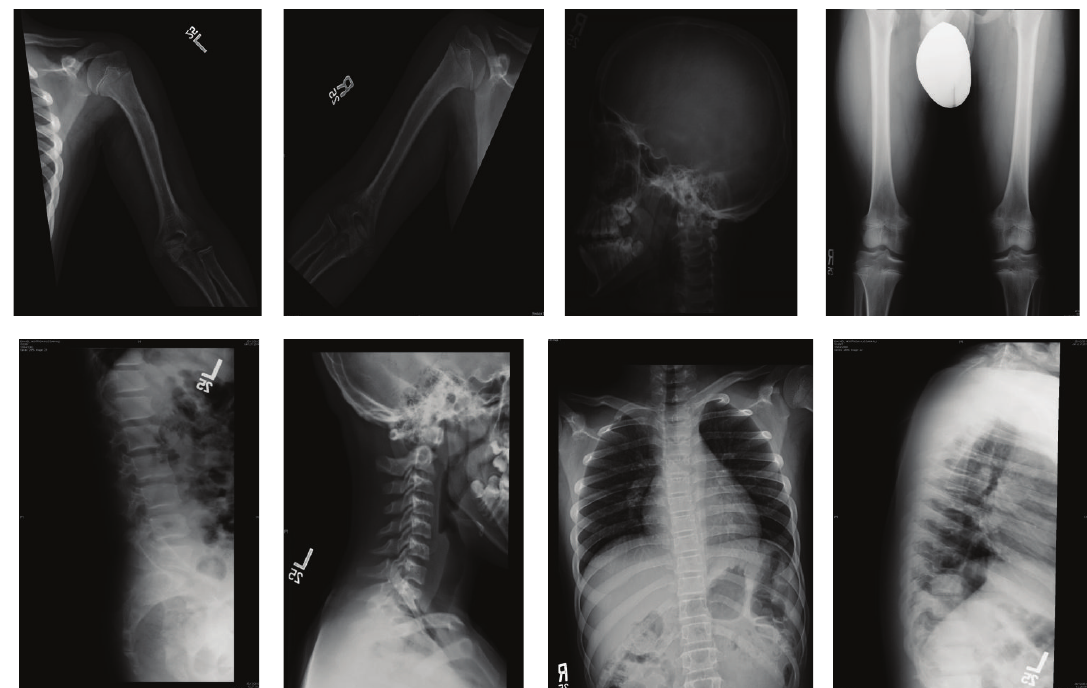
Figure 1: Patient’s skeletal survey in favor of